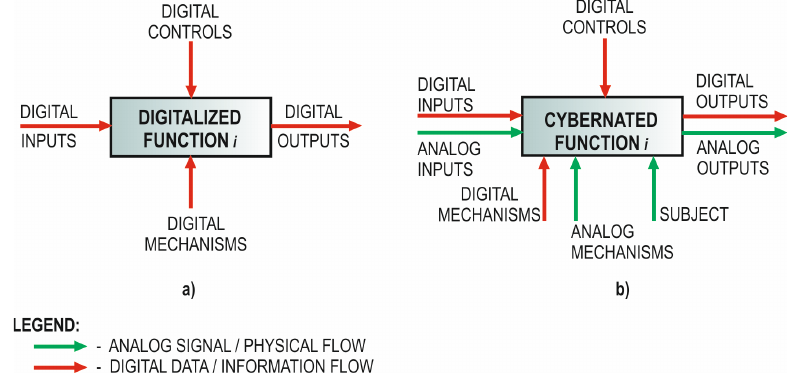
Figure 11. Digitalized and cybernated functions.